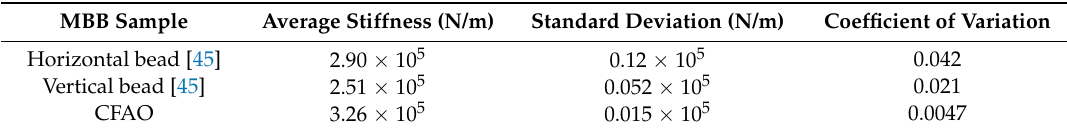
Table 2. Measured stiffness (average of three samples each) of printed CFAO optimized beams with other horizontal ( 𝜃 (cid:3032) = 0 ) and vertical ( 𝜃 (cid:3032) = 90°) beams (cf. Reference [45]) included for comparison.